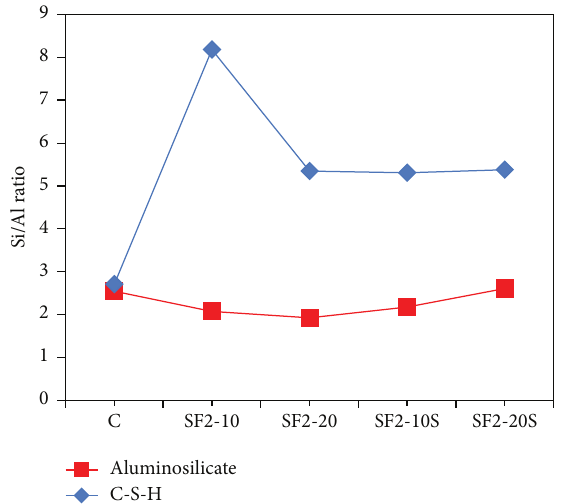
Figure 5: Si/Al ratio of reaction products calculated by applying Si MAS NMR spectra results to Engelhard’s equation